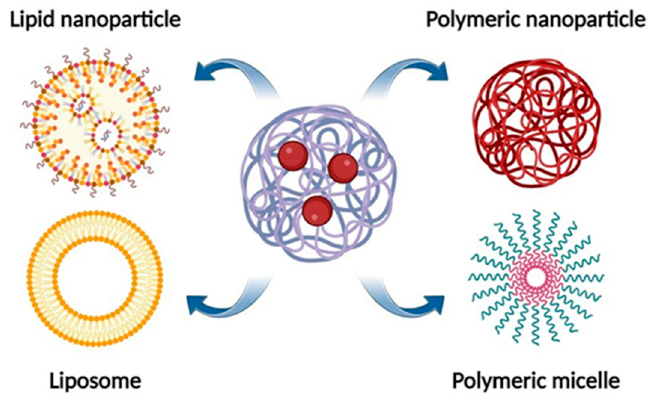
Figure 6. Naringin-loaded nanoformulations for drug delivery systems.